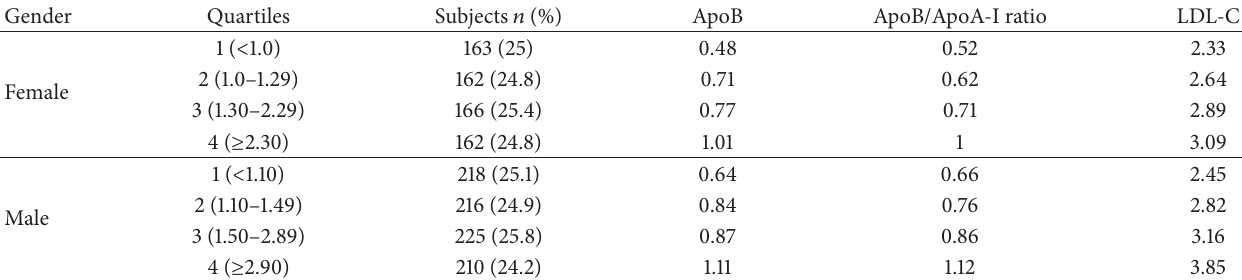
Table 4: Comparison of ApoB and ApoB/ApoA-I ratio with LDL-C among HOMA2-IR quartiles in women and men. Gender